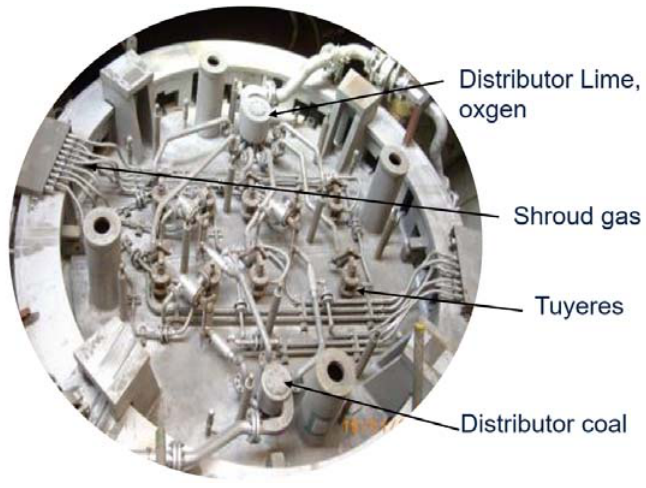
Figure 12. Converter bottom of 100 t JET converter at POSCO, Pohang